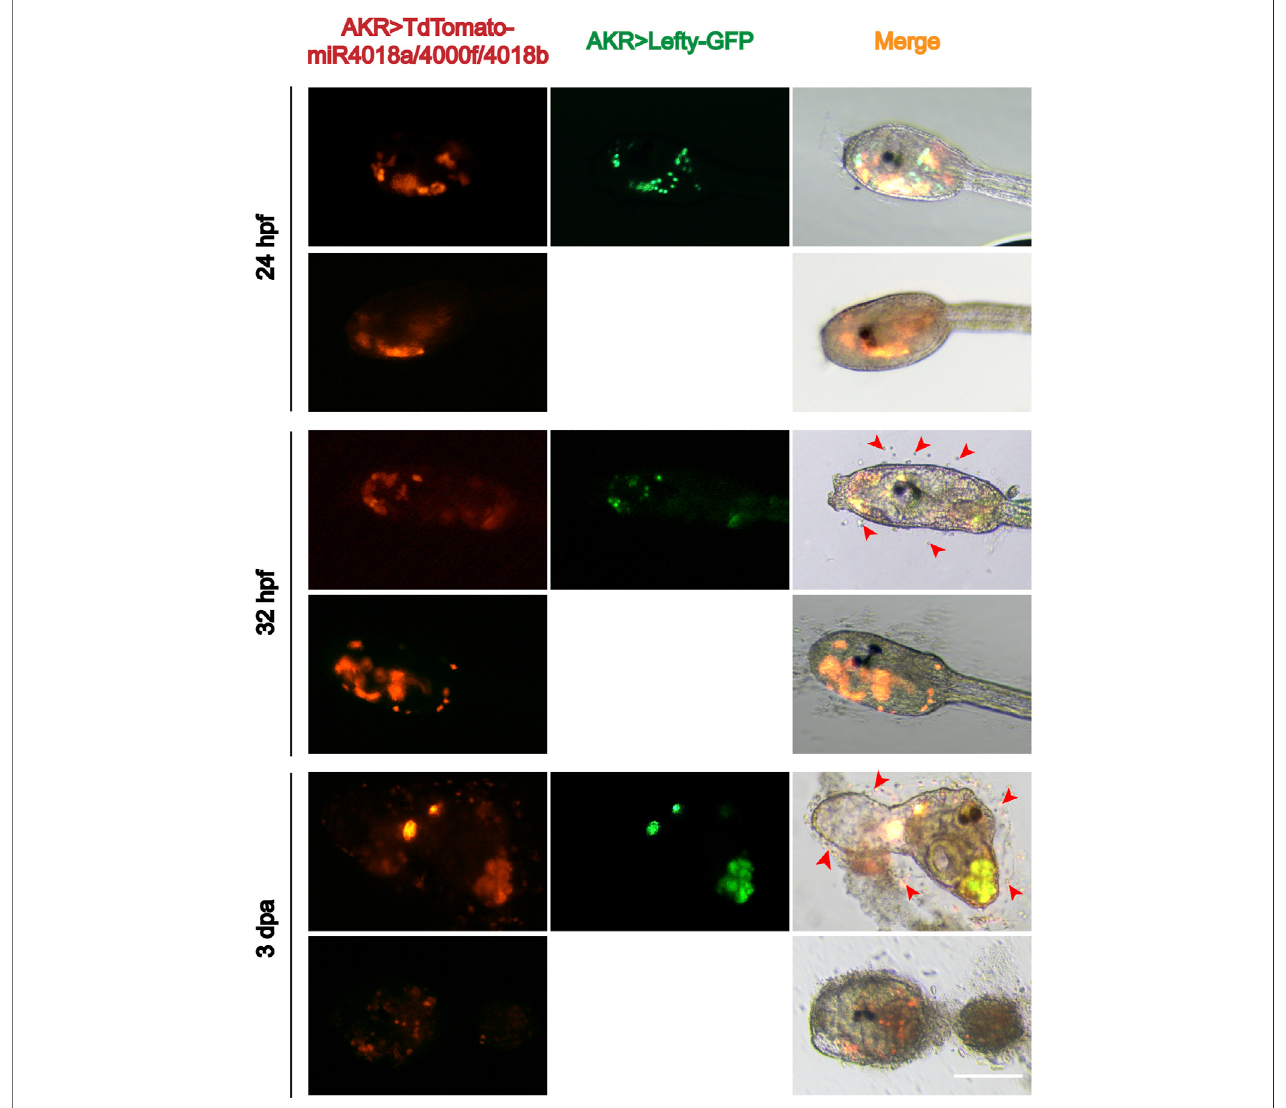
FIGURE 4 | Overexpression of Lefty rescue the phenotype in the miR4018a / 4000f / 4018b -overexpressed larvae. Cellulose and the sporadic tunic cells could be observed in AKR > TdTomato - miR4018a / 4000f / 4018b and AKR > Lefty-GFP coexpressed swimming and metamorphotic larvae at 32 hpf and 3 dpa (red arrowhead) ( n = 22/35). In miR4018a/4000f/4018b -only overexpression group, 25/35 larvae without the tunic. Scale: bar 50 μ m.